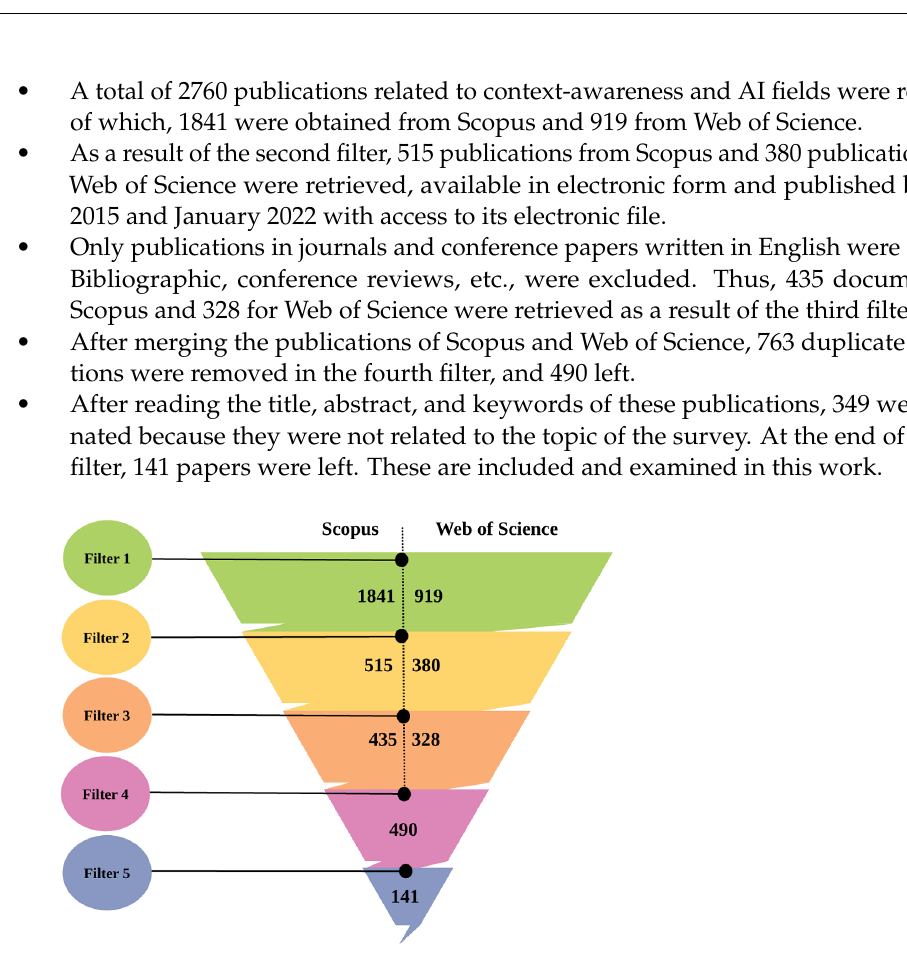
Figure 6. The number of papers selected after applying each filter of the survey’s related papers is given for WoS and Scopus databases,